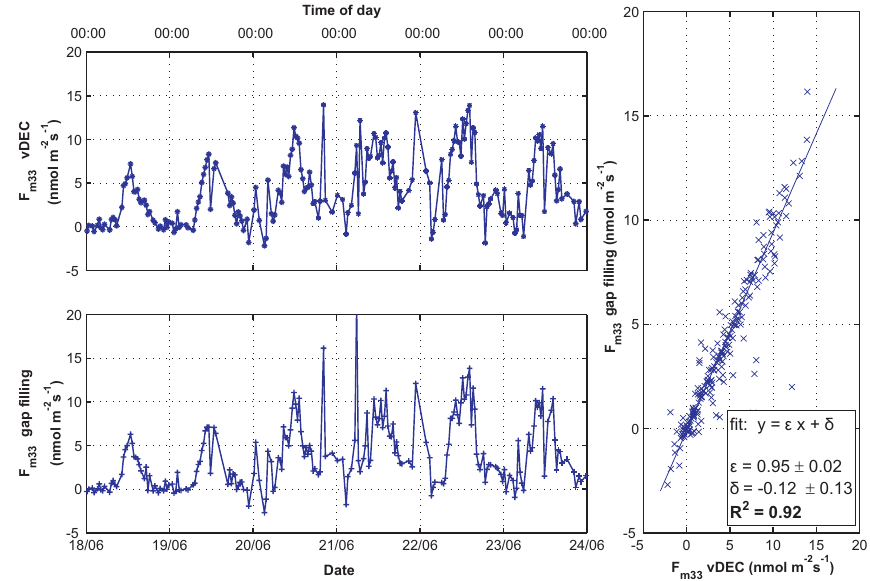
Fig. 6. Methanol fluxes calculated with the vDEC (upper left panel) and the gap filling (lower left panel) method and the scatter plot between both including the regression line. Both fluxes agree with a correlation coefficient of R 2 =